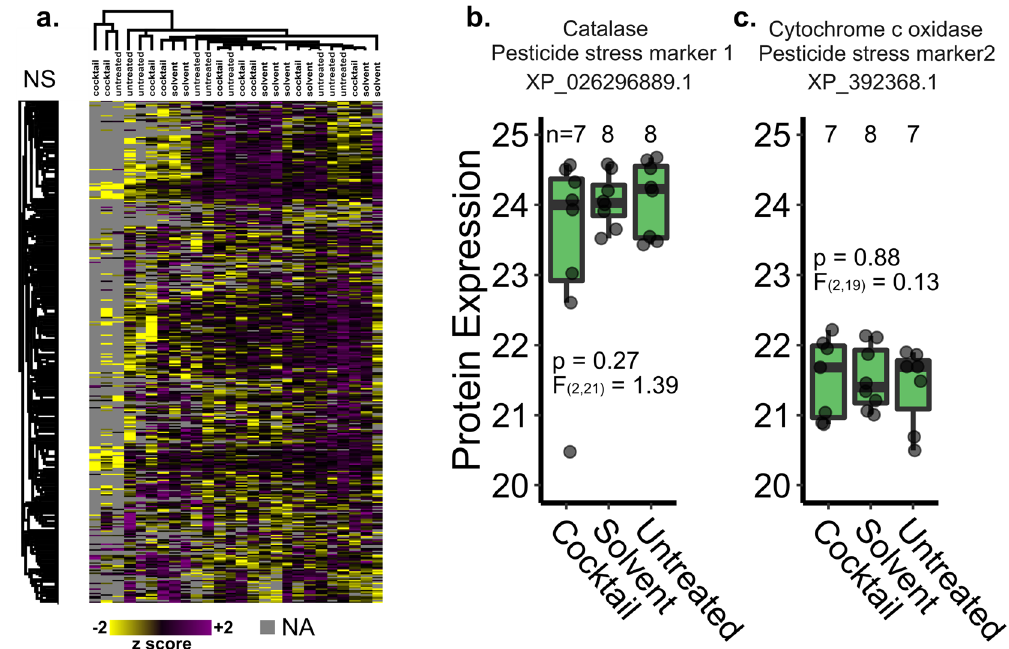
Figure 4. Protein expression in spermathecal fluid of queens treated with a pesticide cocktail. Queens were reintroduced to colonies after topical treatment (2 µl, dosed at 3,500 HQ) and sacrificed for analysis after 2 weeks. No proteins were differentially expressed at a global scale (limma, 10% FDR) (a) and the previously proposed pesticide stress biomarkers were also not differentially expressed (linear model; b & c). Samples and proteins clustered via Euclidian distance, 300 clusters, 10 iterations. Boxes represent the interquartile range, bars indicate the median, and whiskers span 1.5 times the interquartile